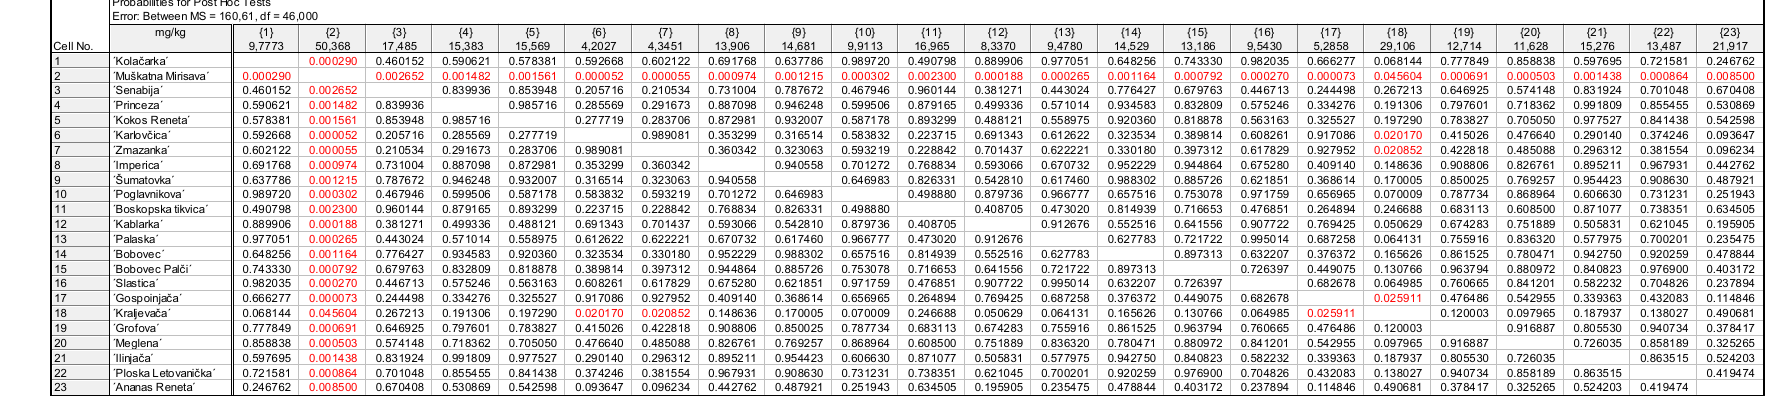
Figure A7. The statistical significance of astragalin in traditional apple varieties; the p -values of the correlations of identified polyphenols. Statistically significant p -values are marked red ( p < 0.05).